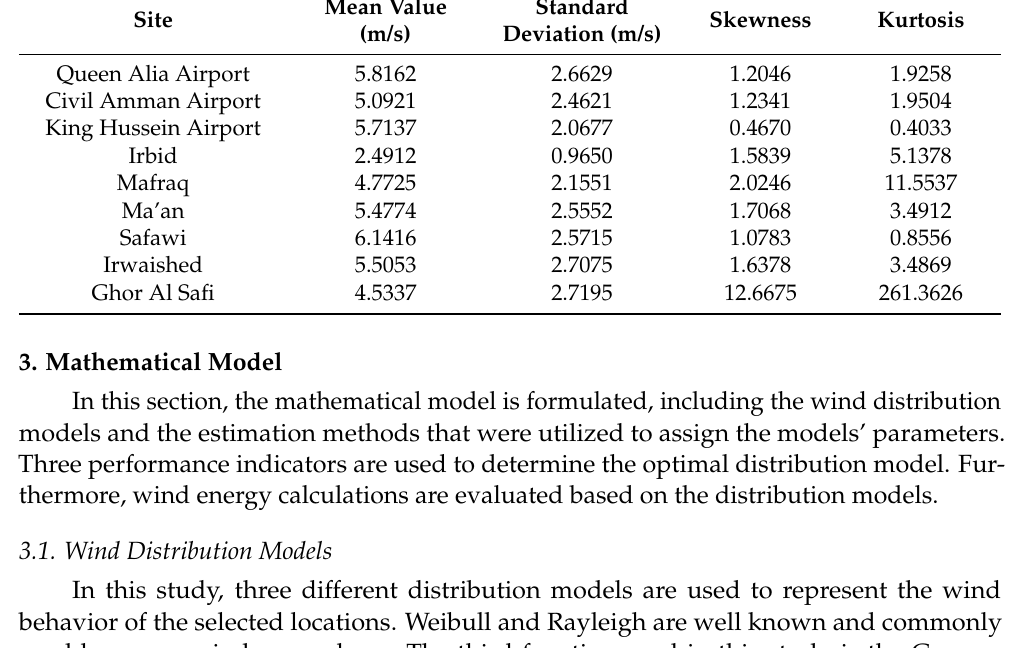
Table 2. Mean wind speed, standard deviation, and distribution pattern of selected wind sites. Mean Value Standard Site (m/s) Deviation